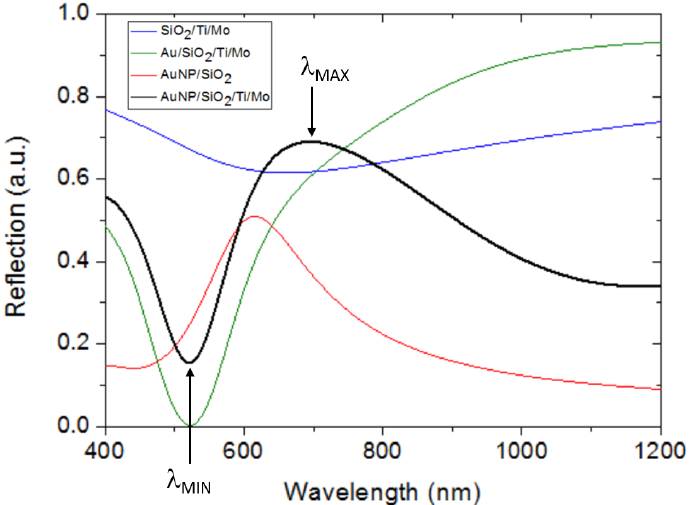
Figure 7. Calculated spectral reflection for different multilayer configurations: SiO 2 (100 nm)/Ti (10 nm)/Mo substrate (blue line), Au (15 nm)/SiO 2 (100 nm)/Ti (10 nm)/Mo substrate (green line), Au NP (100 nm diameter)/SiO 2 substrate (red line), and Au NP (100 nm diameter)/SiO 2 (100 nm)/Ti (10 nm)/Mo substrate (black line). In all cases n B = 1 (air).